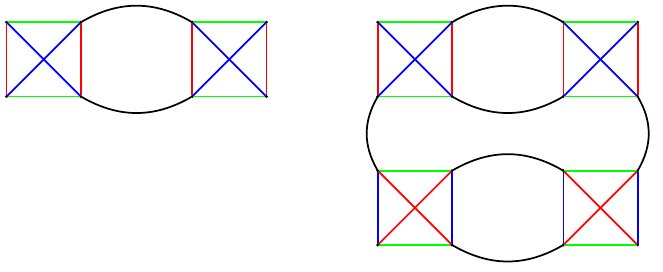
Figure 3 . Two Feynman graphs, with external tensor contractions equivalent to the pillow (left) and double-trace (right)